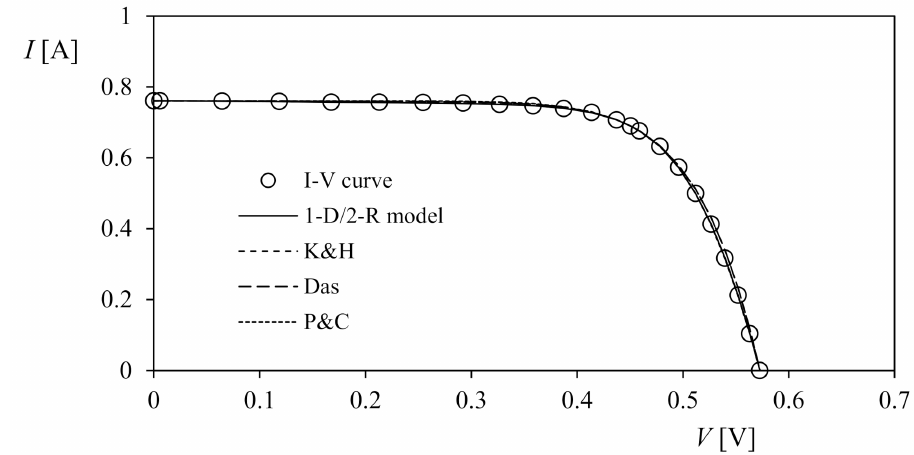
Figure 2. I-V curve of the RTC solar cell [83], with the results from the 1-D/2-R equivalent circuit model, and the explicit models of Kalmarkar and Haneefa, Das, and Pindado and